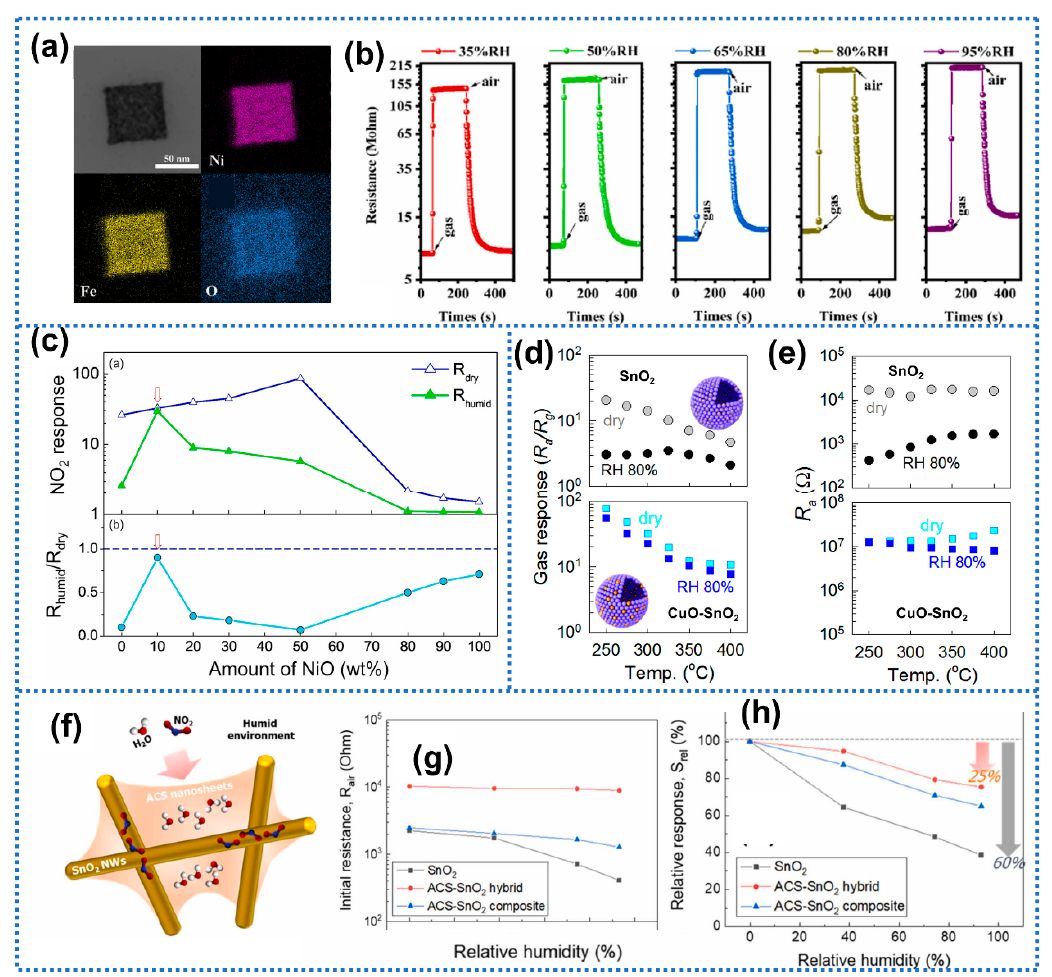
Figure 6. ( a ) The elemental mapping images of NiO/NiFe 2 O 4 -1.5. ( b ) Dynamic sensing curves of NiO/NiFe 2 O 4 -1.5 sensor toward 100 ppm acetone at the working temperature of 200 °C under different RH environments. Reprinted with permission from Ref. [102]. Copyright 2022,